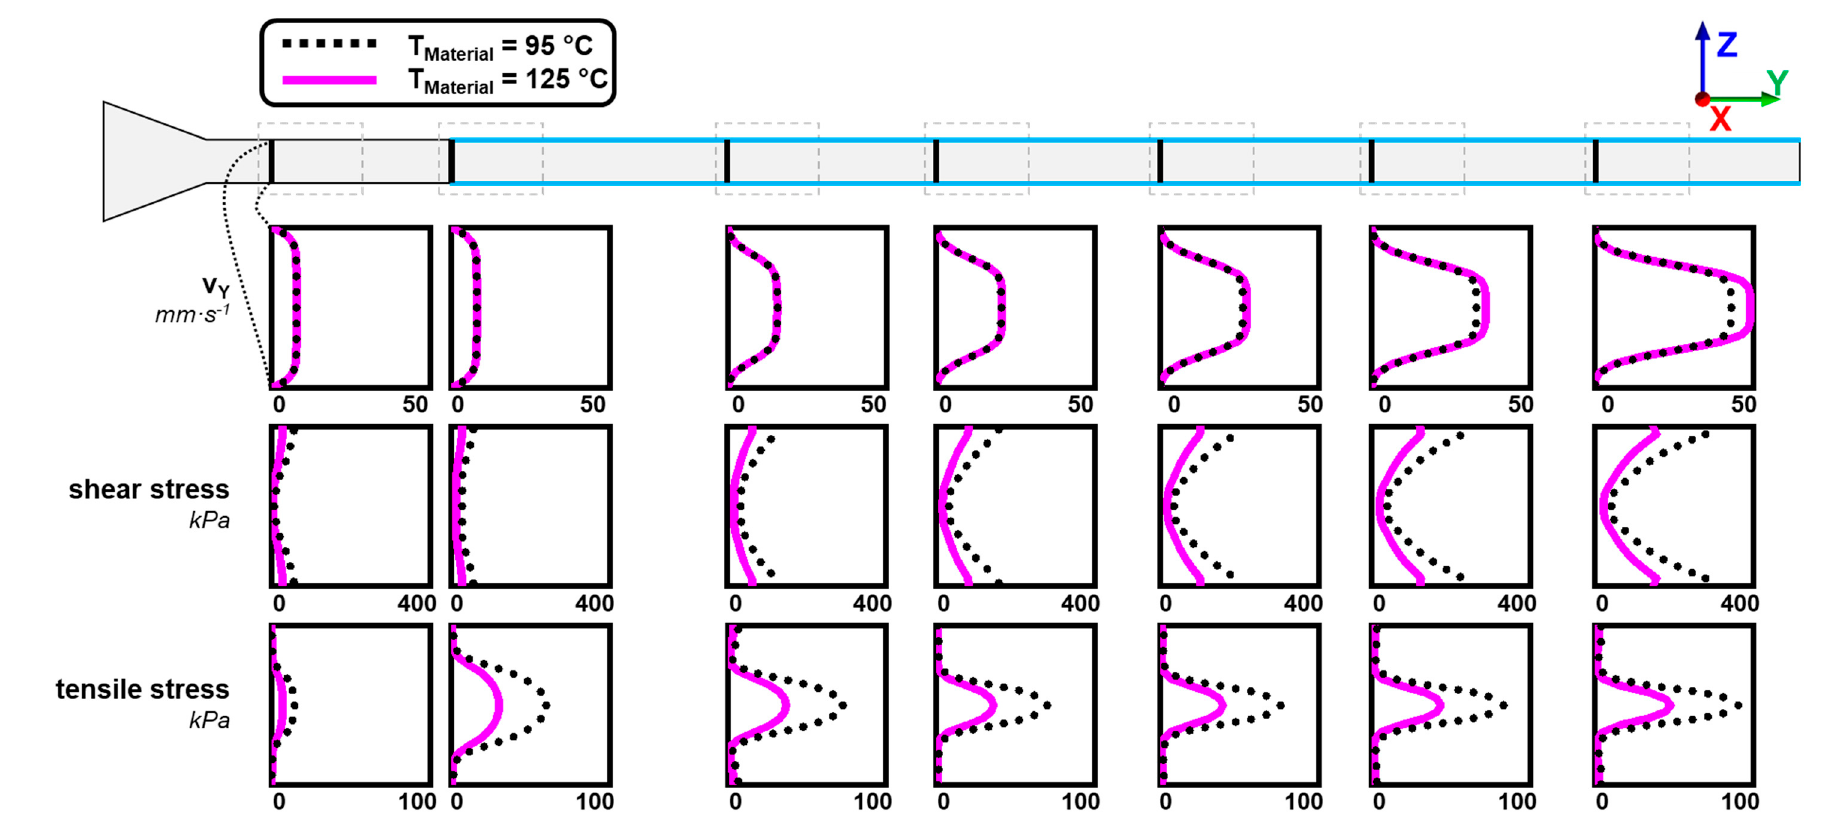
Figure 12. Development of profiles of velocities in the flow direction, shear stresses, and tensile stresses along the die length for both material temperatures 95 ◦ C (black dotted line) and 125 ◦ C (pink solid line). Locations of profile analysis (black solid lines transversely to flow direction) correspond to the location of cryo-sections from the dead-stop experiment (Figure 7), which are marked with the grey dashed lines.